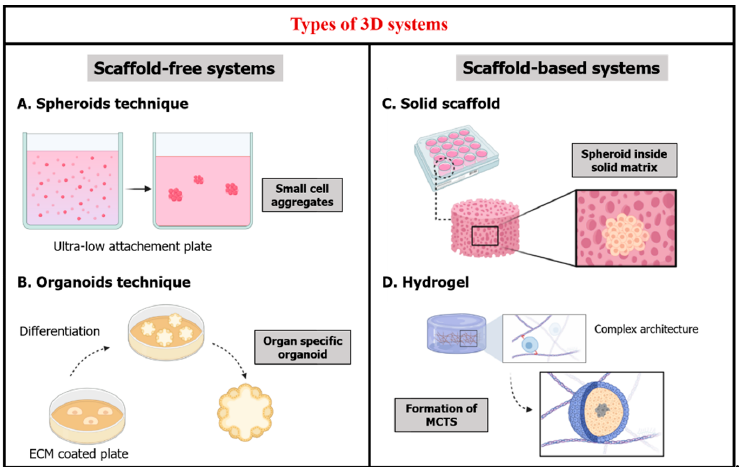
Figure 2. Types of 3D systems. 3D systems fall into two categories either scaffold-free or scaffold- based systems. Scaffold-free systems depend greatly on the plate where the cells are culture whether it is ( A ) ultra-low attachment plate for the production of cell aggregates as spheroids or ( B ) Extracellular matrix (ECM) coated plates for cell differentiation into organoids. Scaffold-based systems are manmade microenvironments that can host cells whether they are ( C ) solid scaffolds that offer a rigid matrix and allow spheroid formation or ( D ) soft scaffolds like hydrogels that contain an ECM-like complex architecture in which multicellular tumor spheroids (MCTS) are produced similar to solid in vivo tumors.